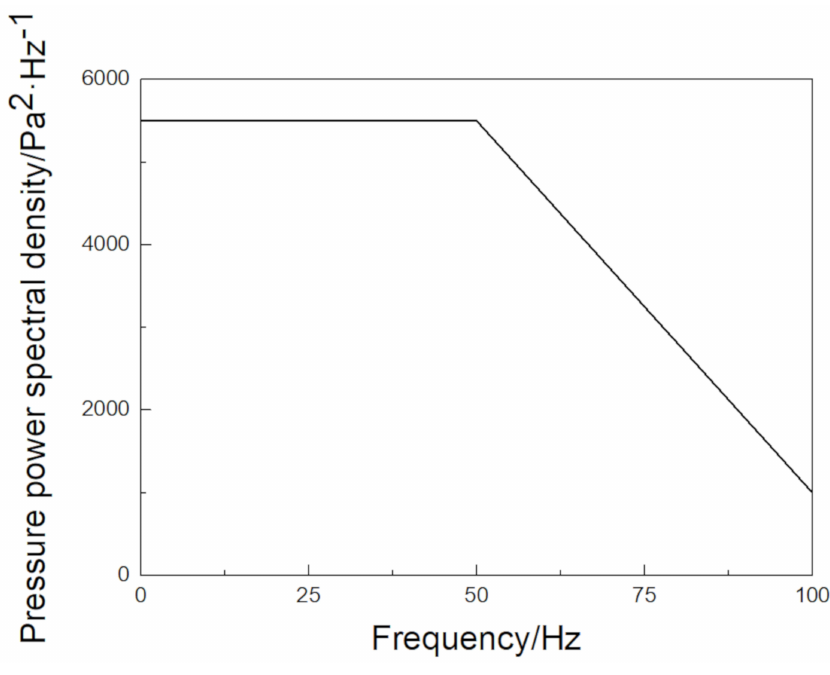
Figure 10. Pressure load spectrum.